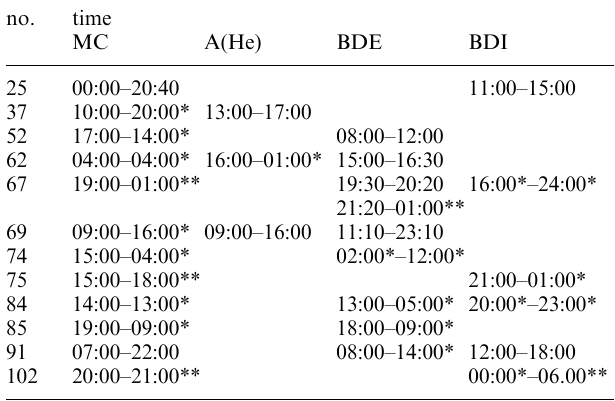
Table 3. Time of observation of di(cid:128)erent signatures